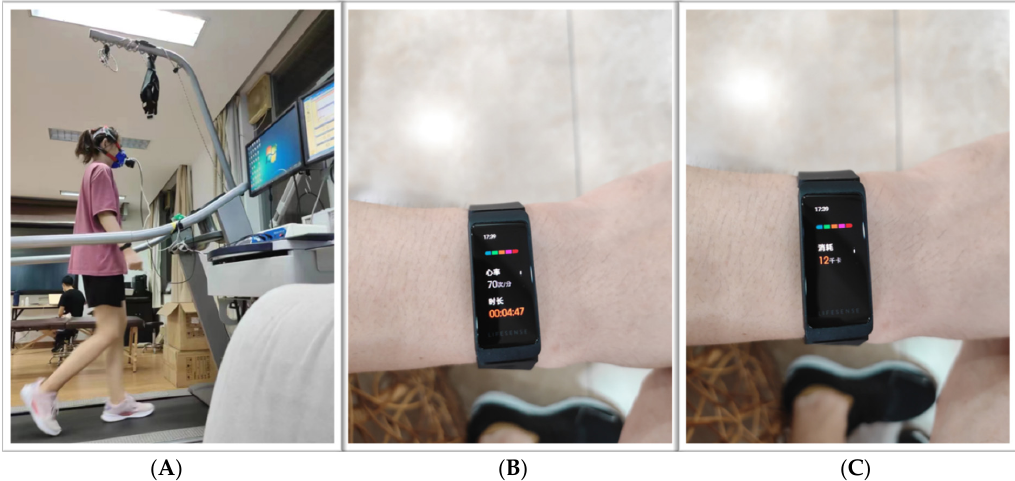
Figure 1. A subject walked on a treadmill with one bracelet on each wrist ( A ), monitoring heart rate ( B ) and energy expenditure ( C ),